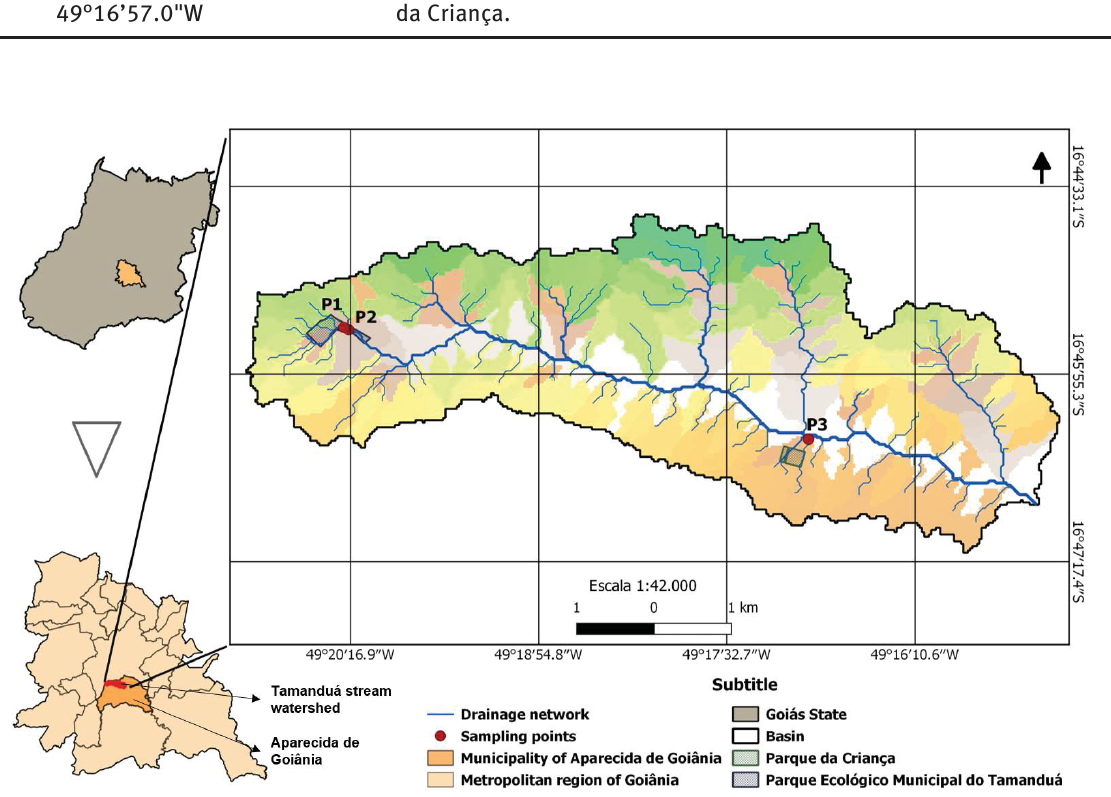
Figure 1: Regional location of the hydrographic basin of the Tamanduá stream in the municipality of Aparecida de Goiânia, with the expan- sion of the area of the basin showing the delimitation of the parks and the location of the sampling points.